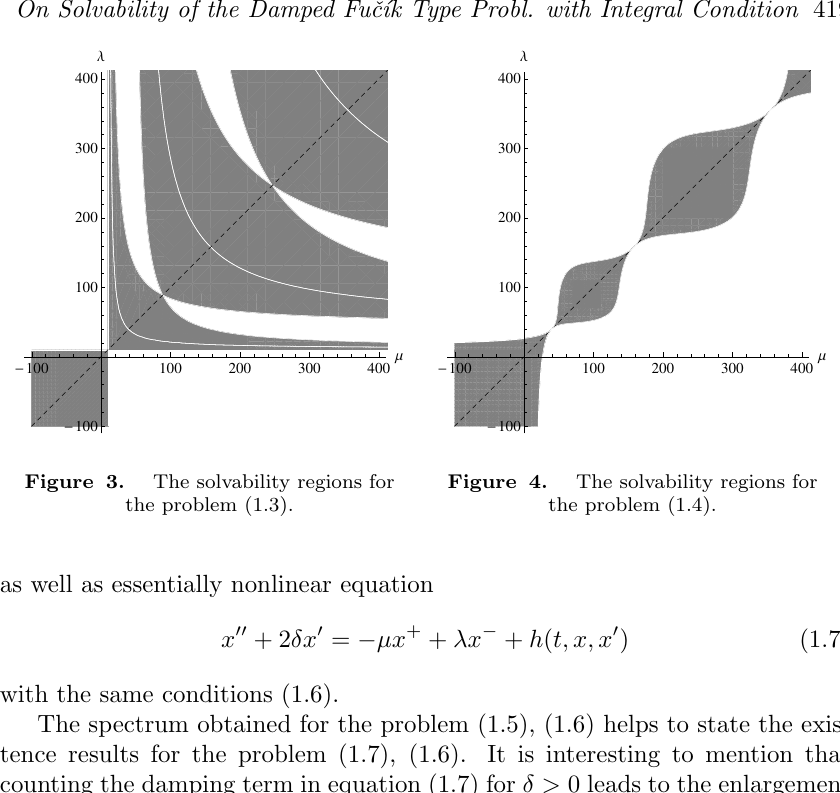
Figure 3. The solvability regions for the problem (1.3).